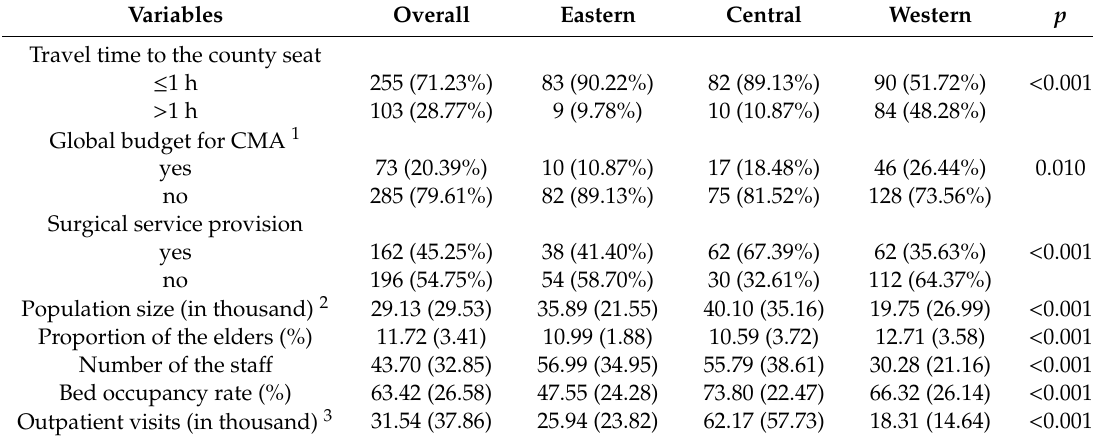
Characteristics of the investigated township health centres in di ff erent regions (frequency / mean(percent / SD)). Overall Eastern